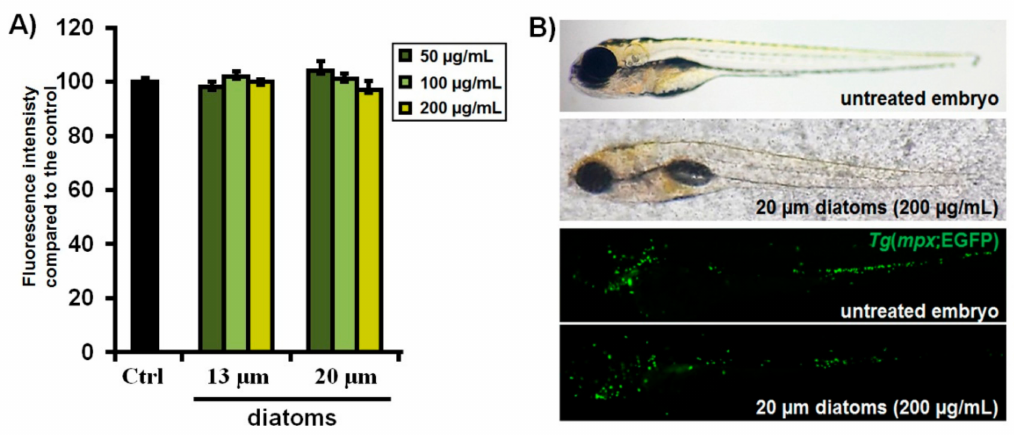
Figure 8. Inflammatory response in Tg ( mpx :EGFP) embryos after the 114-h exposure to the silicate diatoms (13 and 20 µ m in size). Fluorescence intensity of EGFP-labelled neutrophils ( A ) and morphology and neutrophils occurrence within the body of the exposed embryos ( B ) are shown.